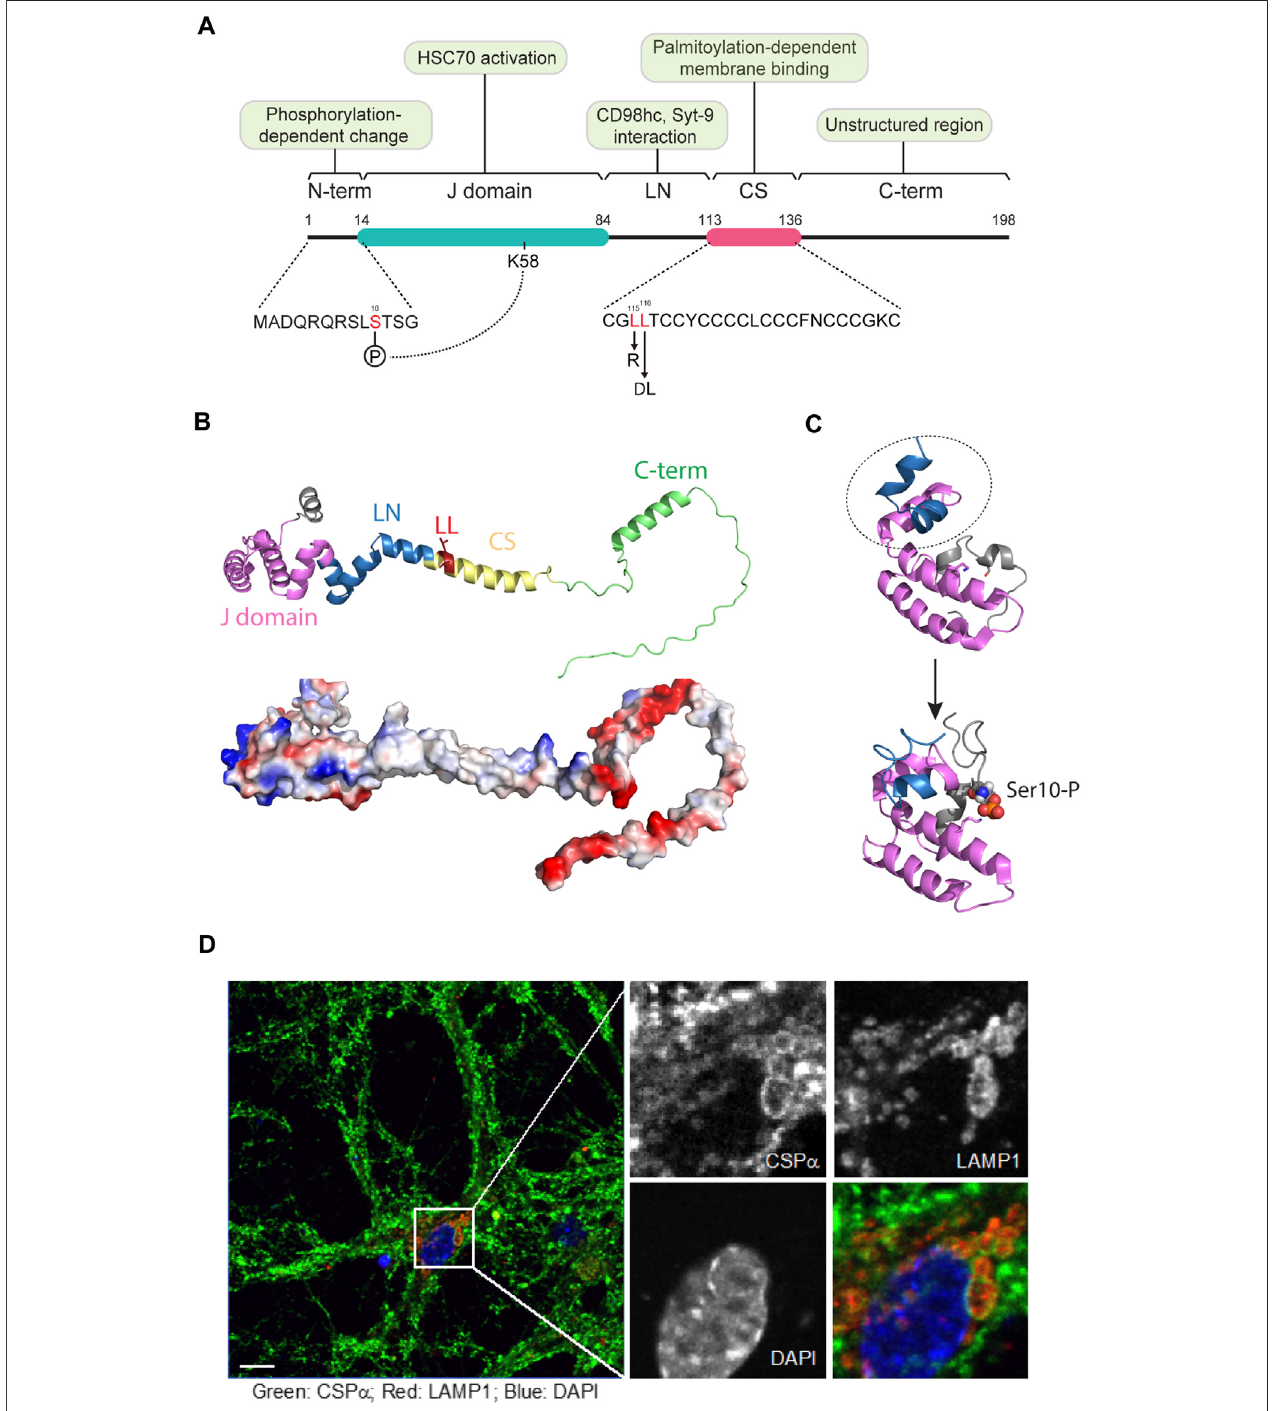
FIGURE 1 | The structure and subcellular localization of CSP α . (A) The domain structure of CSP α . CSP α consists of 5 domains, a small N-terminal (N-term.) segment, a DnaJ (J) domain, a hydrophobic linker (LN), a cysteine string (CS) domain, and a disordered C-term domain. Phosphorylation at Ser10 in the N-domain by PKA or PKB may allow CSP α activation by forming an intramolecular interaction between p-Ser10 and Lys58 in the J domain. The conserved J domain is essential for HSC70 interaction and activation. The LN domain can interact with other proteins such as Synaptotagmin-9 and CD98hc, which regulate SNARE complex assembly and MAPS, respectively. The CS domain possesses 14 cysteine residues for palmitoylation, engaging CSP α to membrane compartments. Mutations in two leucineresidues(L115Rand Δ L116)withintheCSdomainarelinkedtoANCLdisease. (B) Upperpanel,AribbonmodeloffulllengthhumanCSP α predictedbyAlphafold (Identi fi er, AF-Q9H3Z4-F1).Eachdomain islabeled incolors.N-terminaldomain, grey;Jdomain, pink;LNdomain,blue; cysteine-string,yellow;C-terminaldomain, light